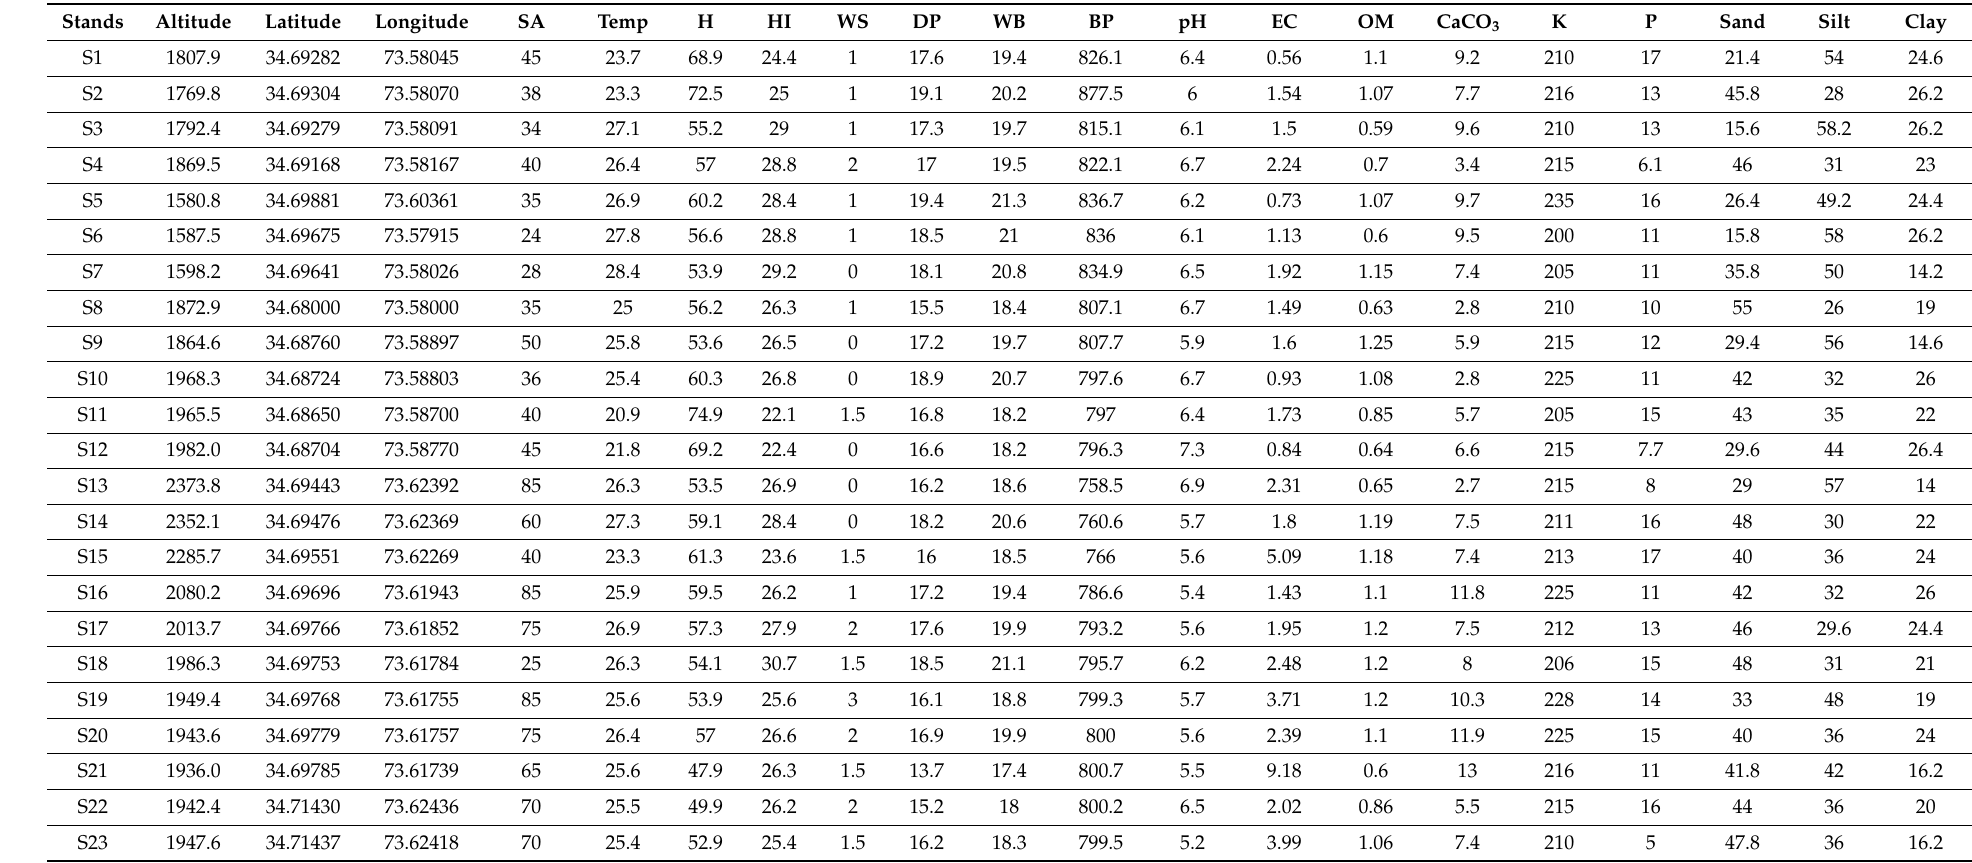
Table 2. Means of geographic and environmental gradients measured at three different transects of each stand were recorded (wind speed averages are given as